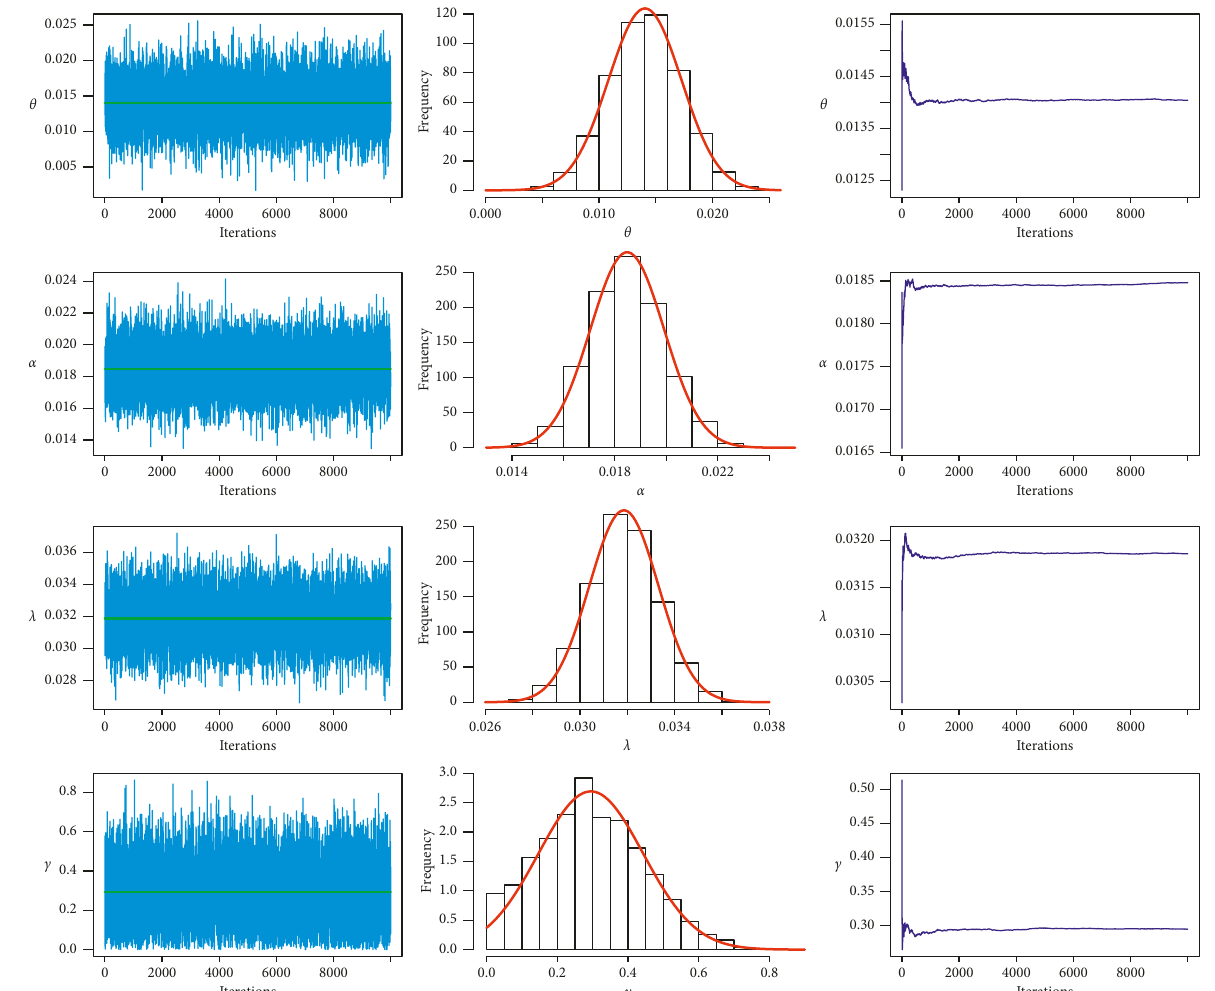
Figure 6: The trace plots, posterior density and the convergence for parameters θ , α , λ and c : flood peaks data.